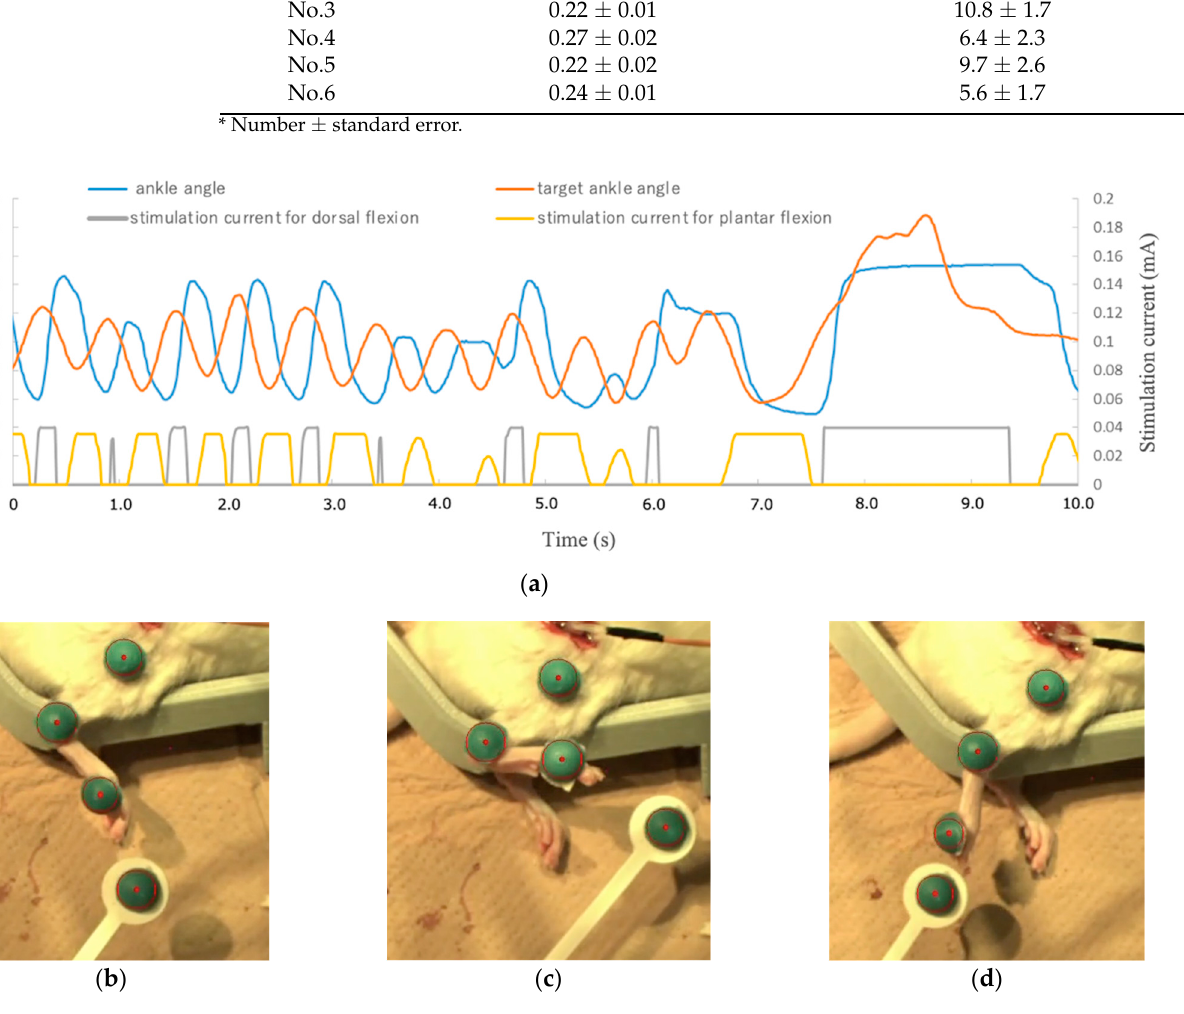
Figure 10. Visual feedback control for reinnervated muscles (previously denervated muscles). ( a ) Relationship between ankle joint tracking with the target and stimulation current. ( b ) No stimulation. ( c ) During dorsiflexion. ( d ) During plantar flexion.